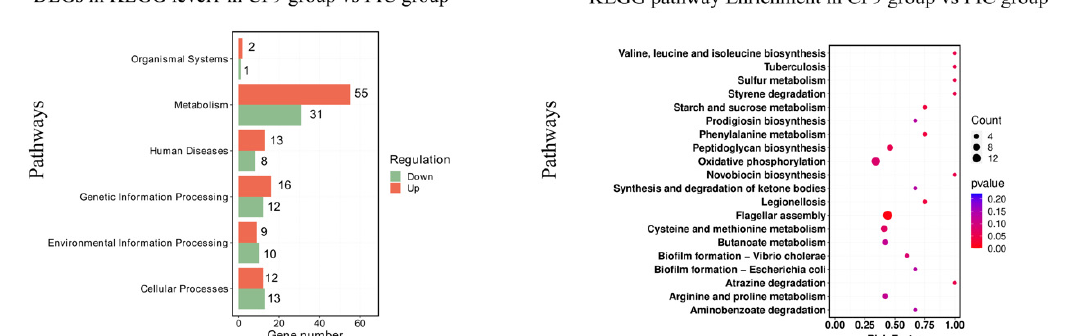
Figure 8. KEGG pathway and enrichment for H. pylori 3192 biofilm under different treatments. For the KEGG pathway database, biological metabolic pathways were divided into cellular processes, environmental information processing, genetic information processing, human diseases,